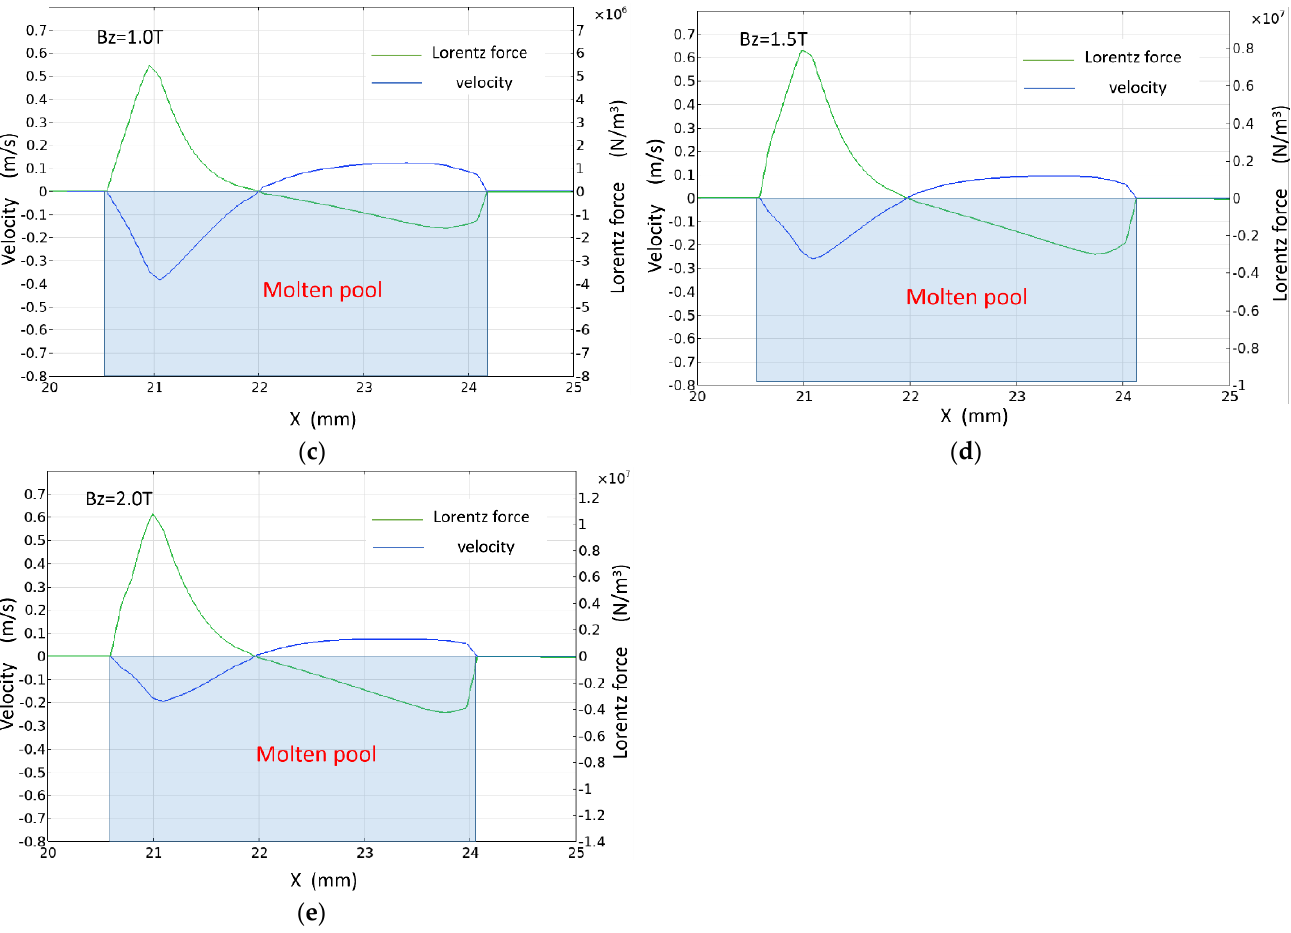
Figure 7. Magnitude of Lorentz force at different magnetic field strengths (t = 4.5 s). ( a ) Bz = 0.0 T; ( b ) Bz = 0.5 T; ( c ) Bz = 1.0 T; ( d ) Bz = 1.5 T; and ( e ) Bz = 2.0 T.